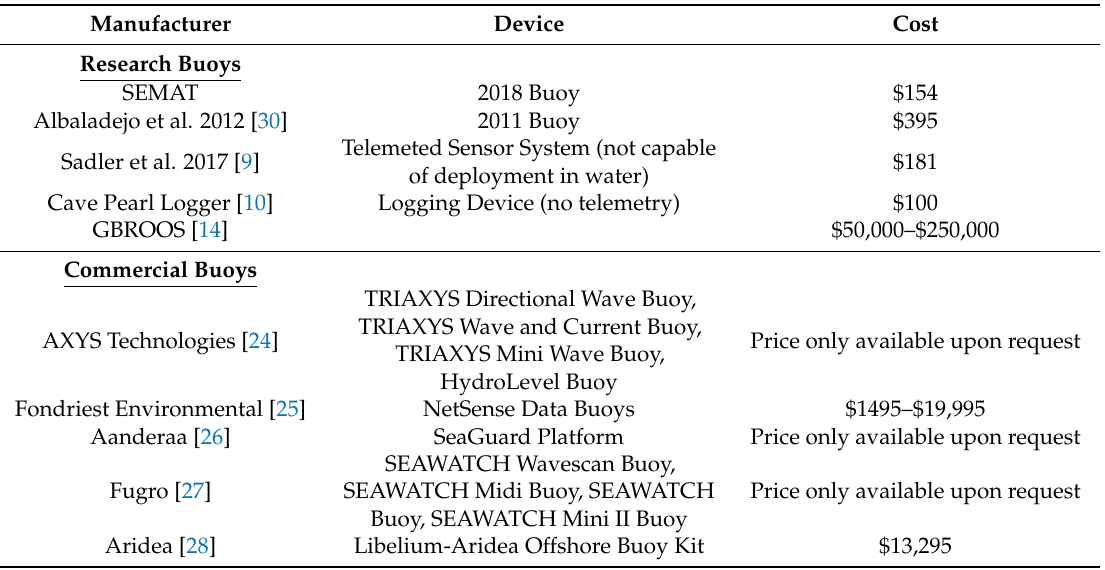
Table 4. Price Comparison of SEMAT against Research and Commercial